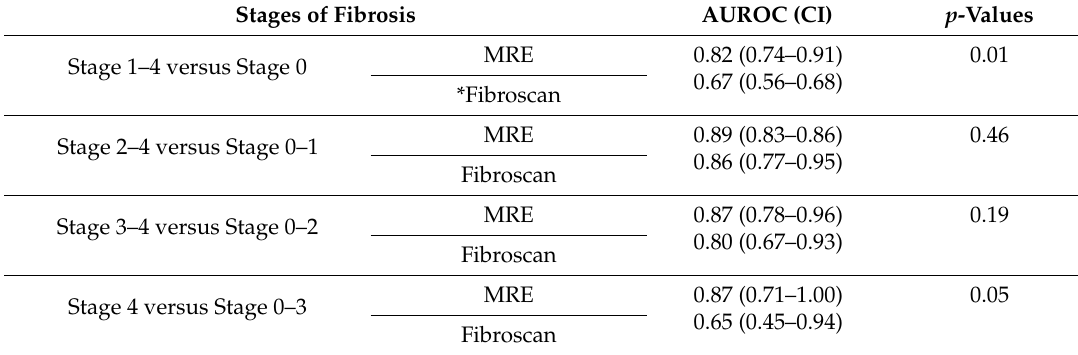
Table 5. Comparison of magnetic resonance elastography (MRE) and transient elastography (TE) for diagnosis of fibrosis